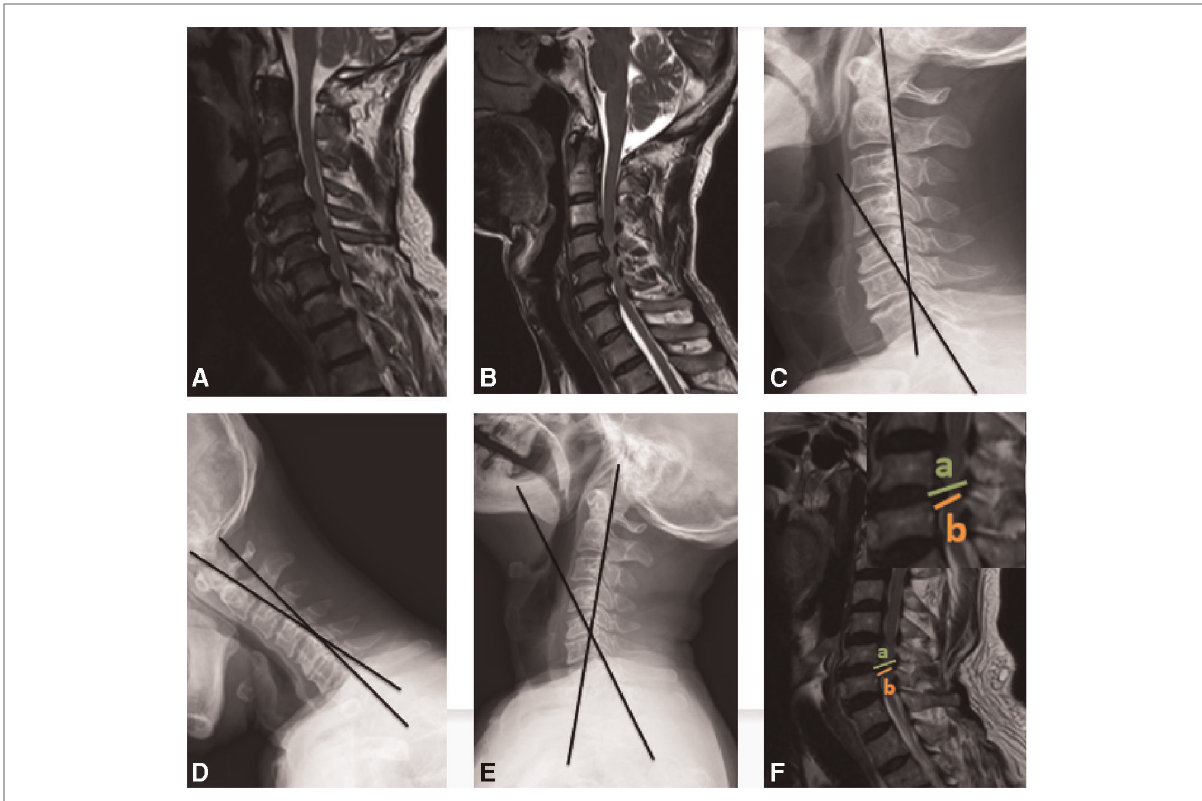
FIGURE 2 The schematic of Group A, Group B, CGA, ROM and thickness of ligamentum fl avum. ( A ) Group A, anterior compression only, without PCSM. ( B ) Group B, both anterior and posterior compression, with PCSM. ( C ) The CGA is measured between the posterior border of the C2 and C7 vertebral body on neutral lateral radiograph. ( D,E ) The C2-7 ROM is calculated as the difference between the CGA measured during the maximal extension and fl exion on the dynamic lateral radiographs. ( F ) The thickness of ligamentum fl avum was measured as the length of (a,b) at the site where the spinal cord was most seriously compressed according to sagittal MR (a was the distance of the anterior border and the posterior border of the spinal canal, b was the distance of the anterior border of the spinal canal and the posterior border of the spinal